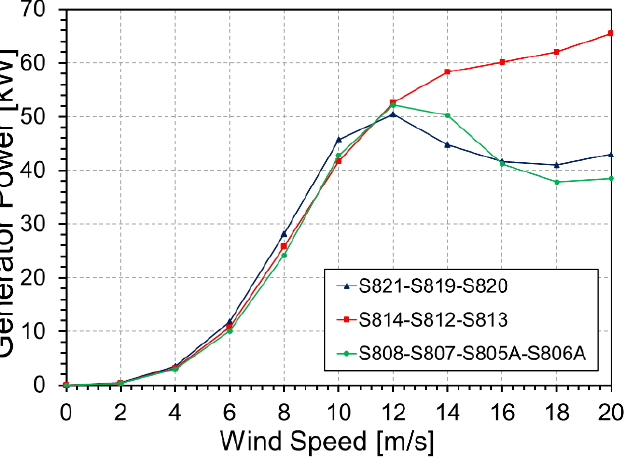
Figure 2. Turbine curves of generator power from the steady simulations in OpenFAST. Maximum rotor speed was set to 60 rpm.